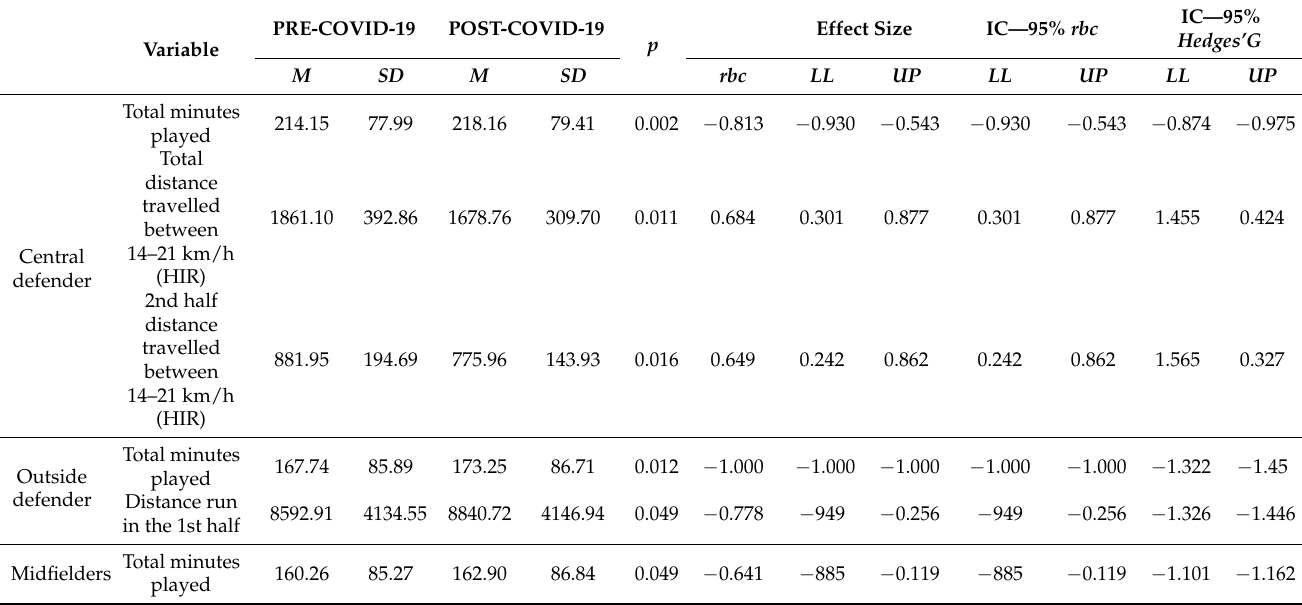
Table 3. Analysis by play position for all players together, weighted bythe number of matches played before and after the isolation